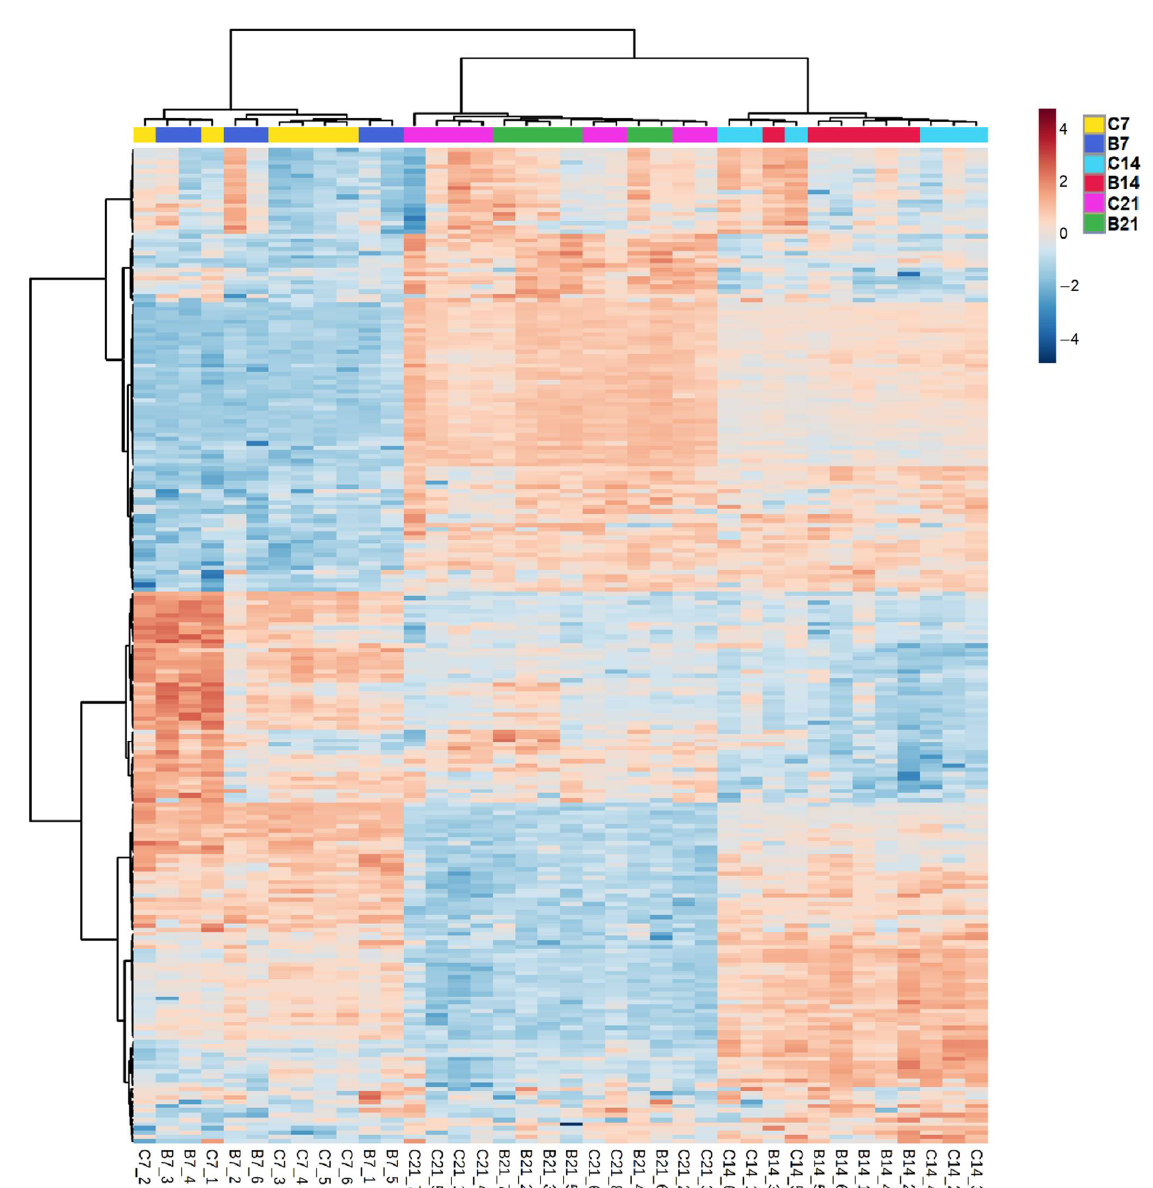
Figure 3. Hierarchical clustering coupled with heatmap of the lipid profiles of Azospirillum-inoculated (B) and non-inoculated roots (C) of Brachypodium harvested at 7, 14, and 21 DAI. The lettering at the bottom of the heatmap indicates the replicates: for each replicate, blue and red colors indicate the lower or higher abundance of specific lipids compared to the other replicates, with darker colors indicating more pronounced differences.